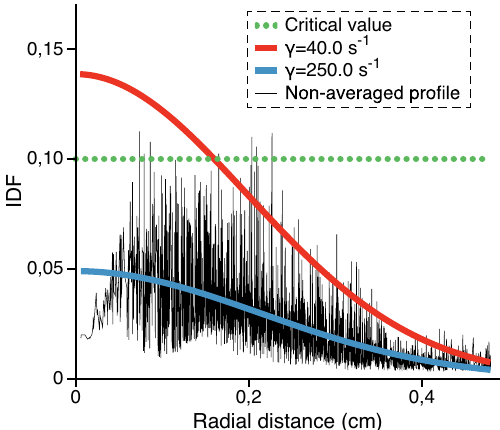
v B , 15000 e , v fl = =